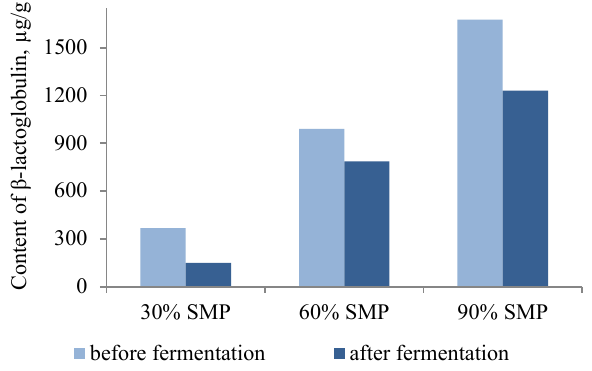
Figure 7 Electrophoregramme samples: control bread sample with SMP = 30% (1), SMP = 60% (2), SMP = 90% (3); experiment bread samples with SMP = 30% (4), SMP = 60% (5), SMP = 90% (6), and the marker